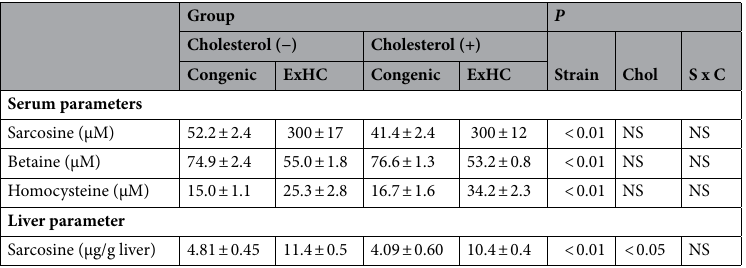
Table 4. Serum and hepatic parameters associated with sarcosine metabolism in ExHC and congenic rats. Values are shown as means ± SEM. n = 6/group, S × C, strain × cholesterol interaction. * P , two-way ANOVA. NS in the table is the abbreviation for “not significant”.